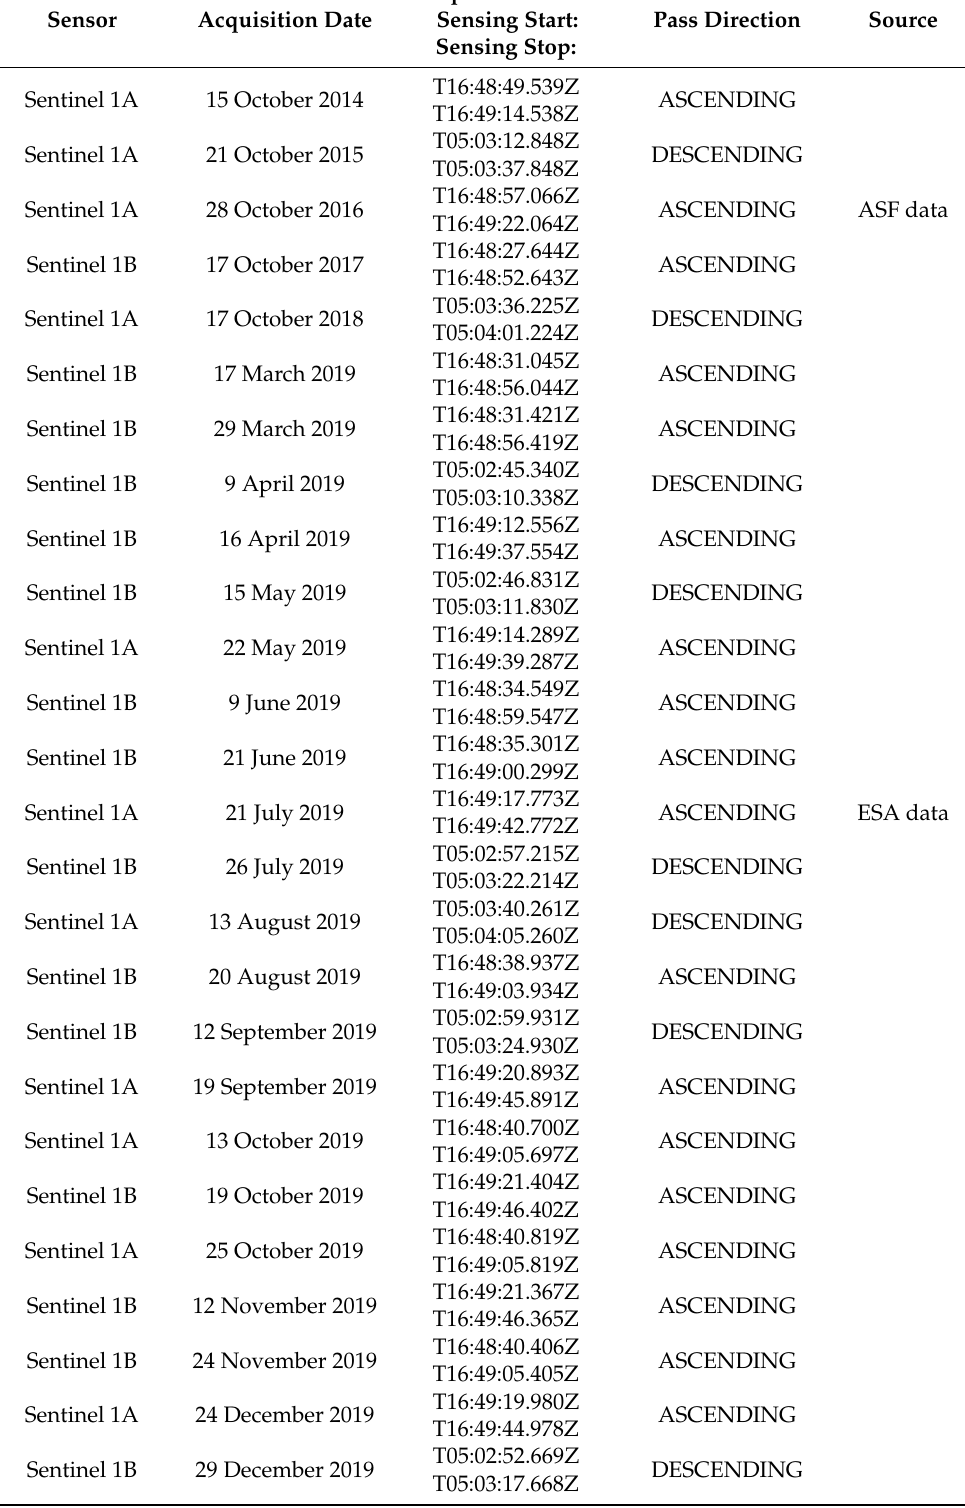
Table 1. Data collection of the study, including the Sentinel 1 sensor type, acquisition date and time, the pass direction, and the